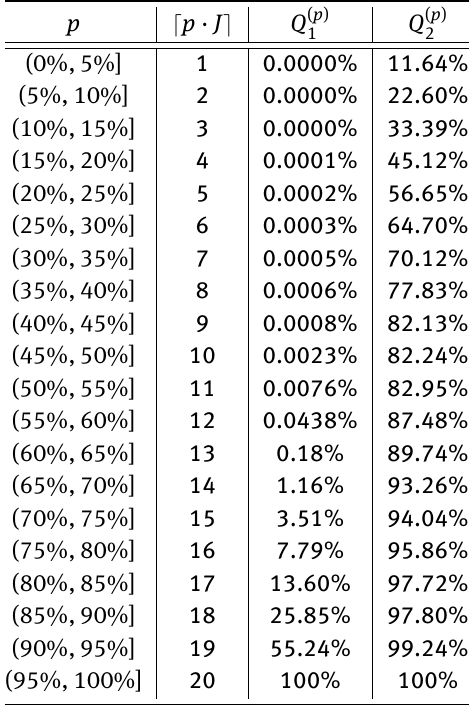
Table 2: Table representing Q ( p ) 1 and Q ( p ) 2 values corresponding to a simulated J = 20 dimensional portfolio, for every p ratio.